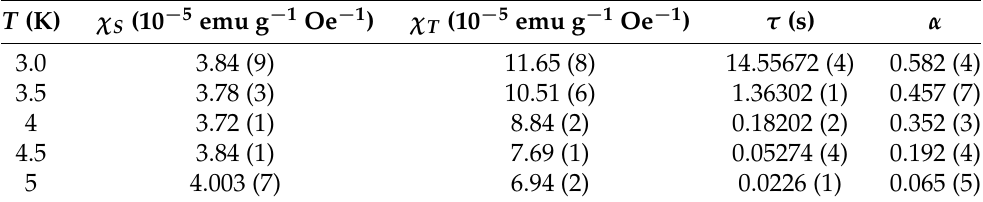
Table 1. Fit parameters obtained from AC susceptibility data for sample SilS-Mn 12 using the extended Debye